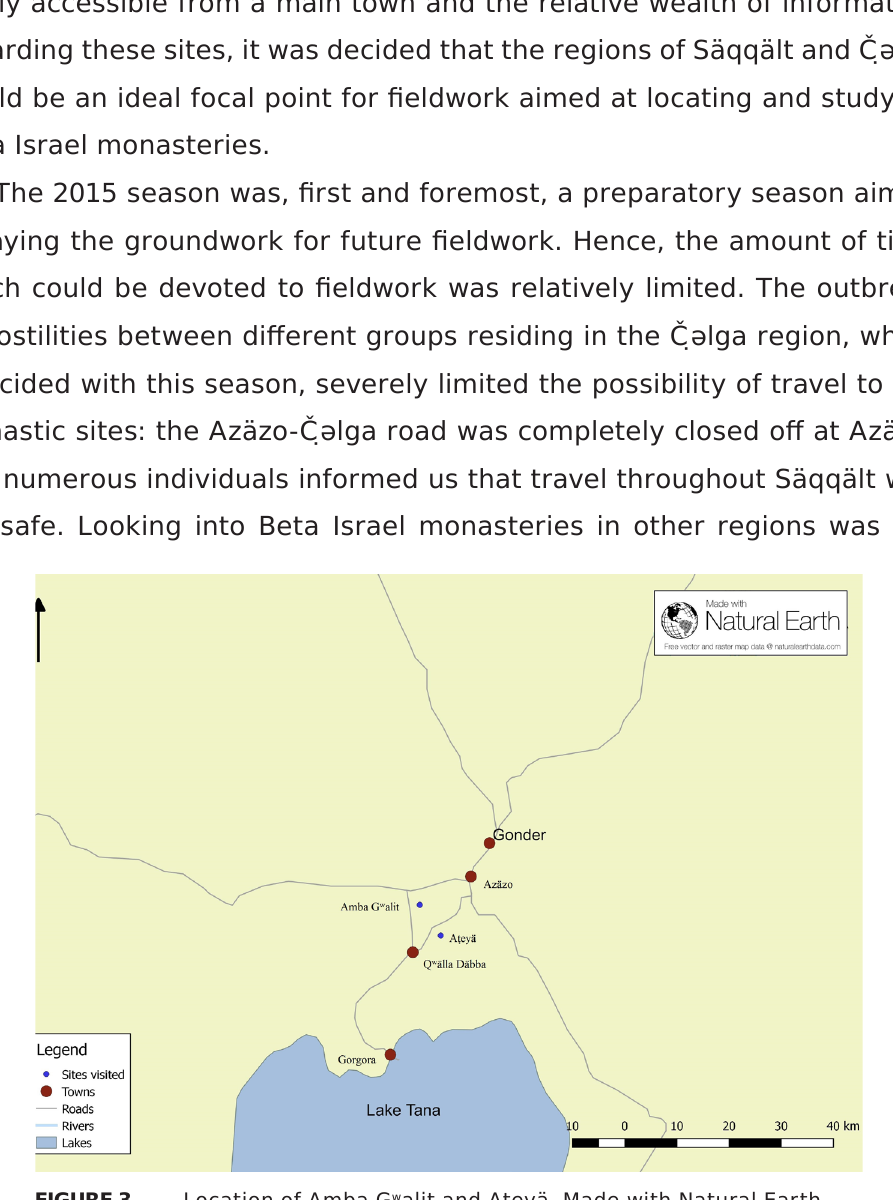
FIgure 3 Location of Amba G w alit and Aṭeyä. Made with Natural Earth (Free vector and raster map data @